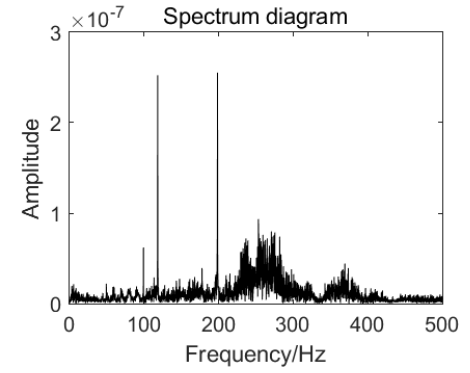
Figure 4. Cloud chart of microseismic energy of 1366 working face.